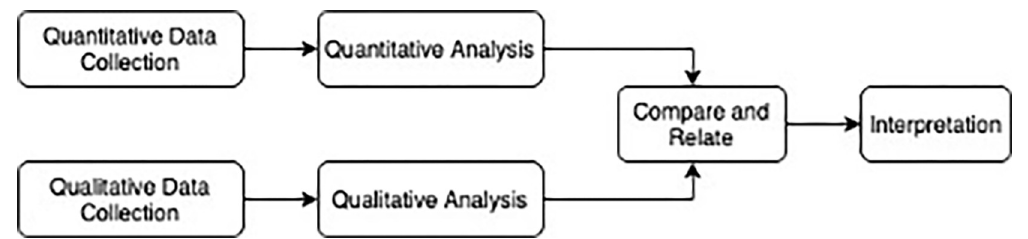
Fig 1. Triangulation of qualitative and quantitative data from collection to